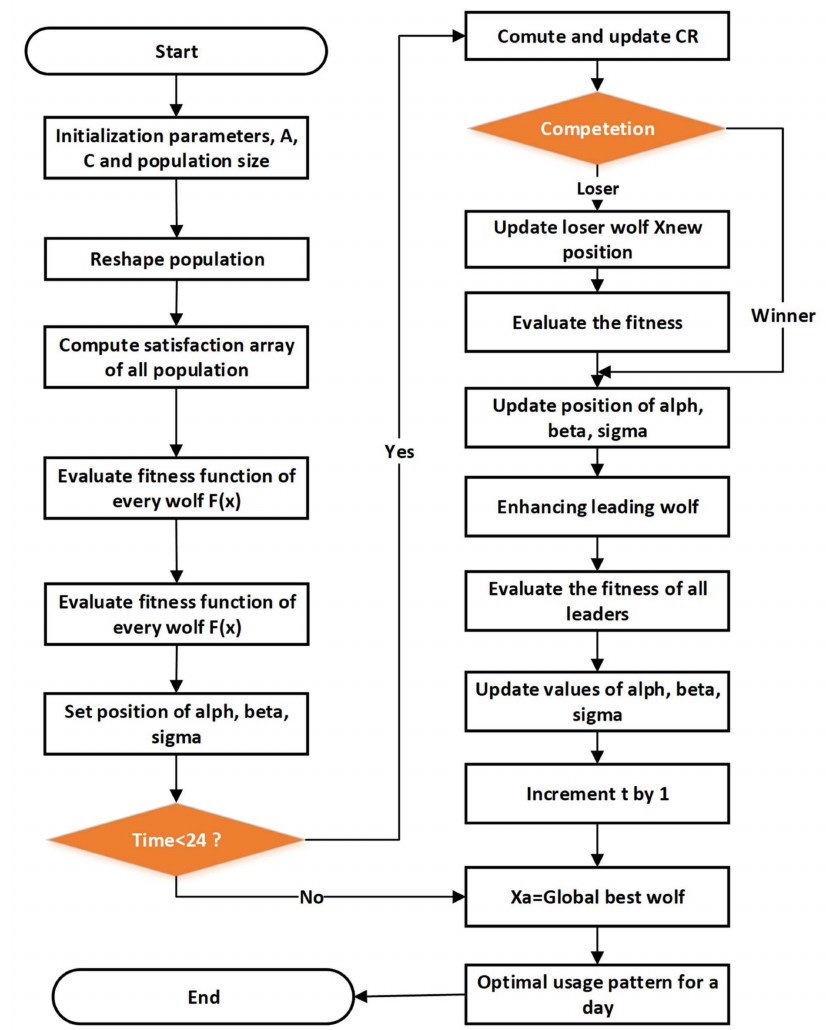
Figure 6. Flow diagram of grey wolf